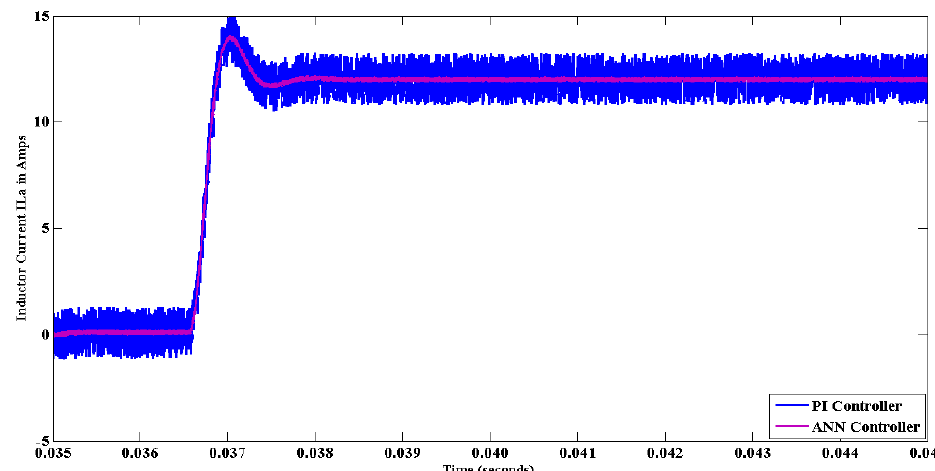
Figure 23. Regulated current step variations in inductor currents at high bus voltage.